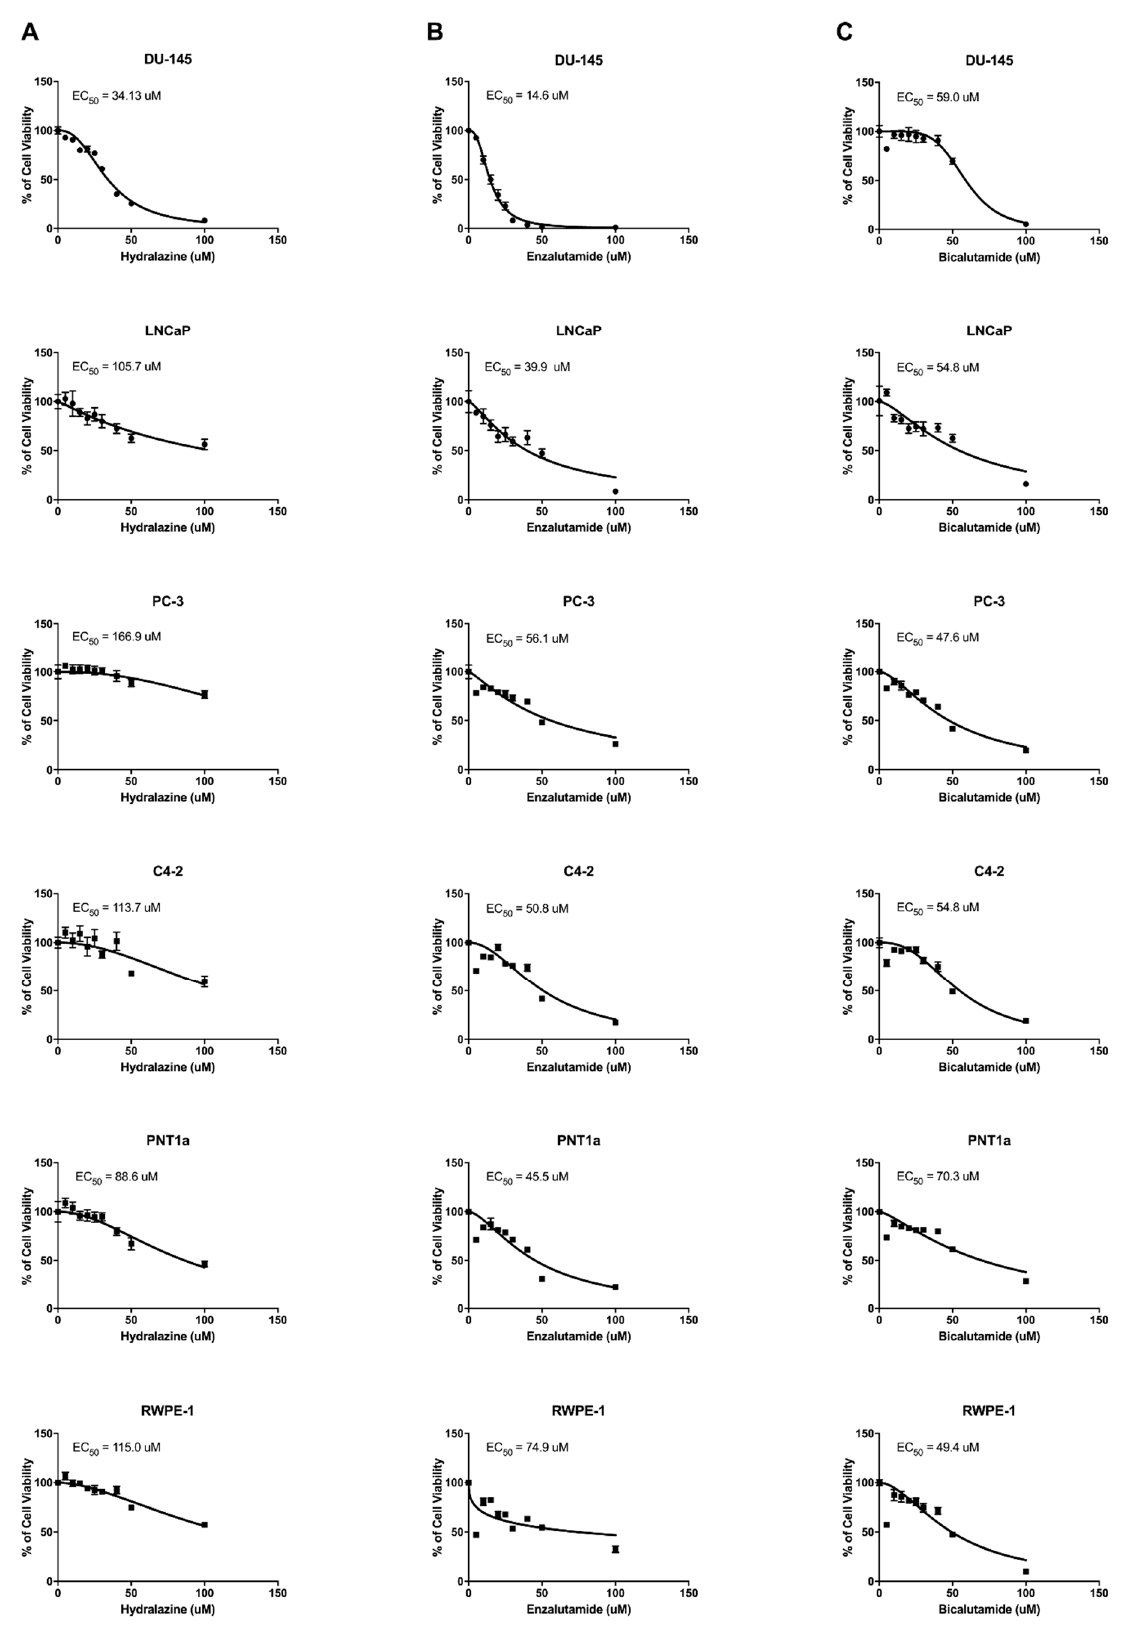
Figure 1. Dose–response curves of prostate cell lines upon hydralazine ( A ), enzalutamide ( B ), and bicalutamide ( C ) treatment. EC 50 values after 72 h of treatment are indicated in each graph.